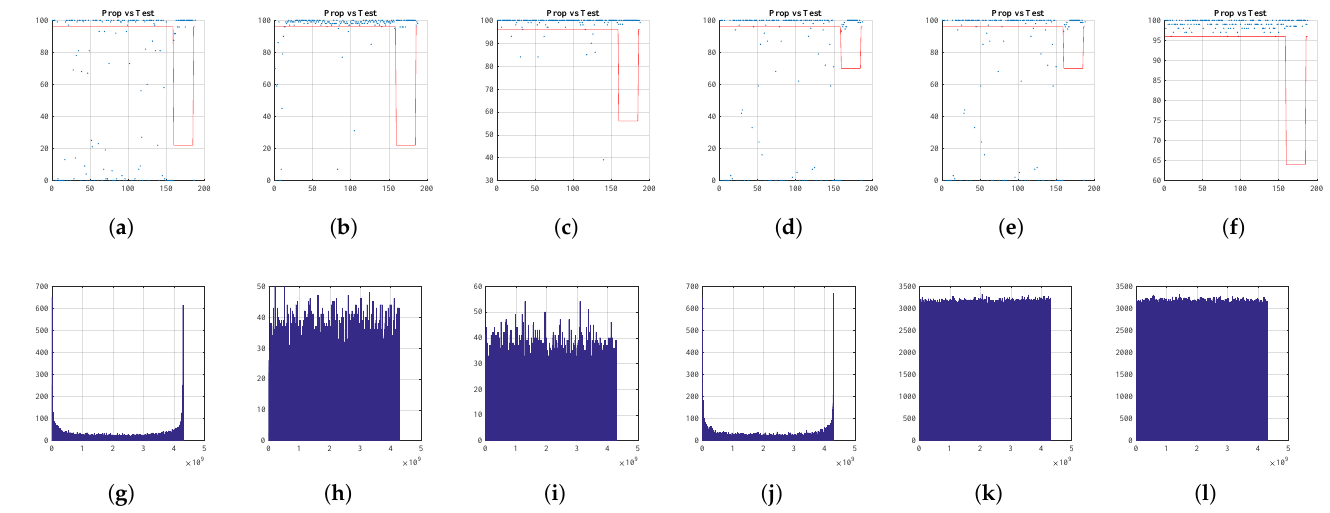
Figure 2. NIST test and histograms of studied chaotic maps, 32-bit LFSR, and the 3D-Chebyshev coupled with the 32-bit LFSR. ( a ) NIST test results of the discrete Logistic map. ( b ) NIST test results of the discrete Skew-Tent map. ( c ) NIST test results of the discrete PWLCM map. ( d ) NIST test results of the discrete 3D-Chebyshev map. ( e ) IST test results of the 32-bit LFSR. ( f ) NIST test results of the discrete 3D-Chebyshev map coupled with LFSR. ( g ) The histogram of a sequence XL . ( h ) The histogram of a sequence XS . ( i ) The histogram of a sequence XP . ( j ) The histogram of a sequence XT . ( k ) The histogram of a sequence Q . ( l ) The histogram of a sequence XTI